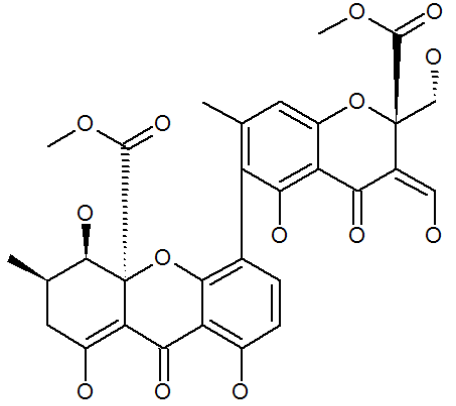
Figure 7. The structure of purpureone.